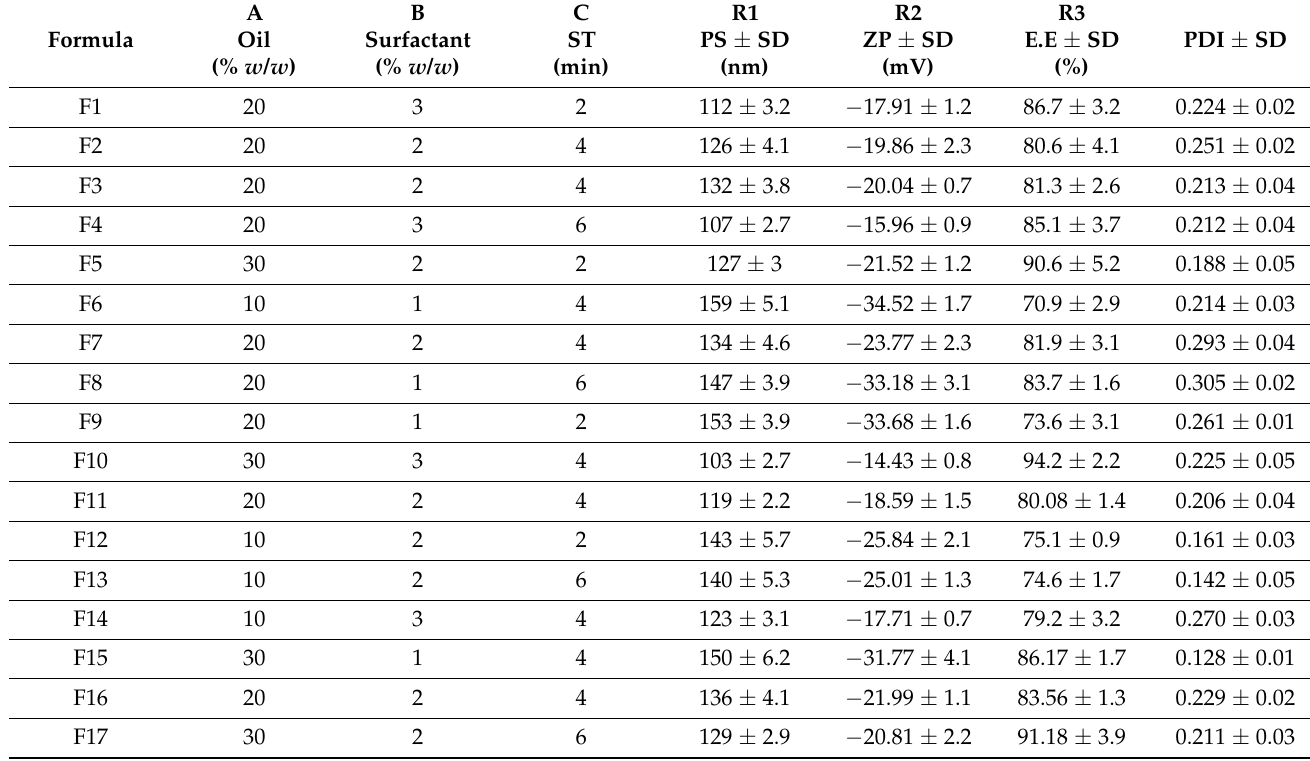
Table 2. Composition matrix of the NIC–NLC formulations with observed